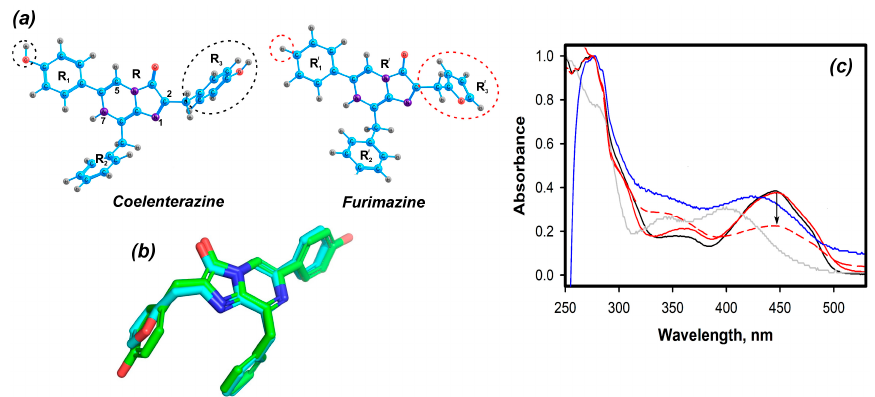
Figure 1. ( a ) Atomic structures of coelenterazine and furimazine substrates. Functional groups R 1 (R’ 1 ), R 2 (R’ 2 ), R 3 (R’ 3 ), and chromophore R (R’) for CTZ and FMZ, respectively. The dotted circle shows different parts of the molecules. The C, O, H, and N atoms are colored blue, red, gray, and purple, respectively. ( b ) CTZ and FMZ superposition. ( c ) Absorbance spectra of: CBP (black line), FMZ-apoCBP (red line), FMZ-apoCBP plus Ca 2+ (blue line), FMZ (gray line), FMZ-apoCBP after 45 days of storage in solution at 8 °C (red dotted line). Spectra are normalized at the short wavelength maximum.